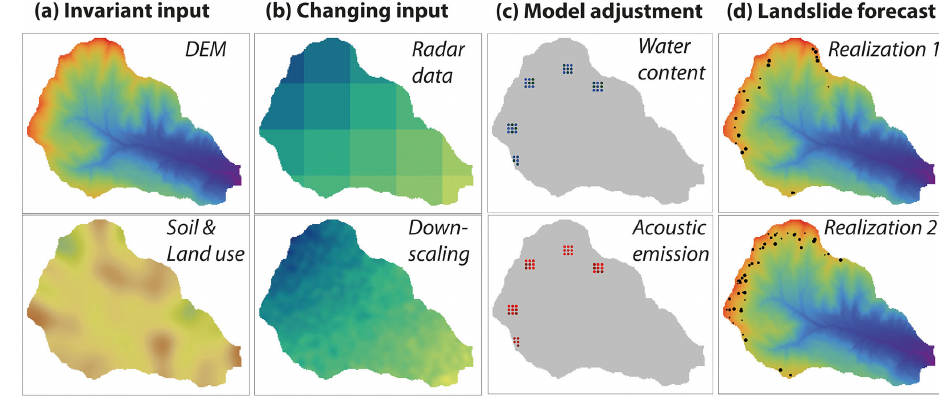
Figure 3. Example of possible future landslide forecasting system at catchment scale. Based on a digital elevation model (DEM) and information on soil type and land use (a) , the triggering model will compute the loading and failure patterns using rainfall data (radar values downscaled by disaggregation model) as input (b) . Water content and mechanical precursor values measured with a network of wireless sensors (c) can be compared to model predictions. In a series of model simulations the time, position and volume of the landslide triggering will be predicted. The ensemble of several realizations will be used to forecast the triggering (d)